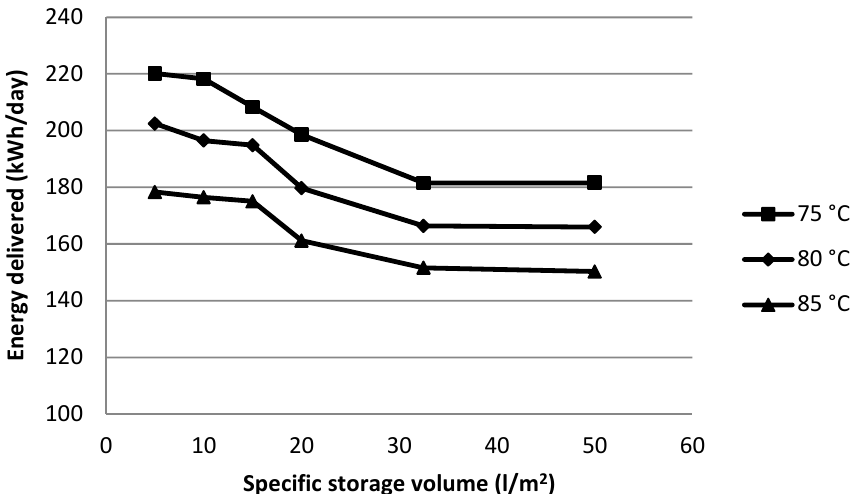
Figure 7. E ff ect of the driving temperature and the specific storage volume on the fraction of solar radiation usable to drive the absorption machine.